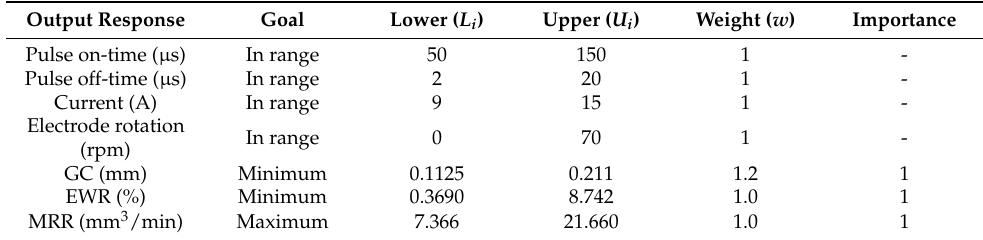
Table 10. Criteria for multi-response optimization of EDM with multi-aperture flushing.